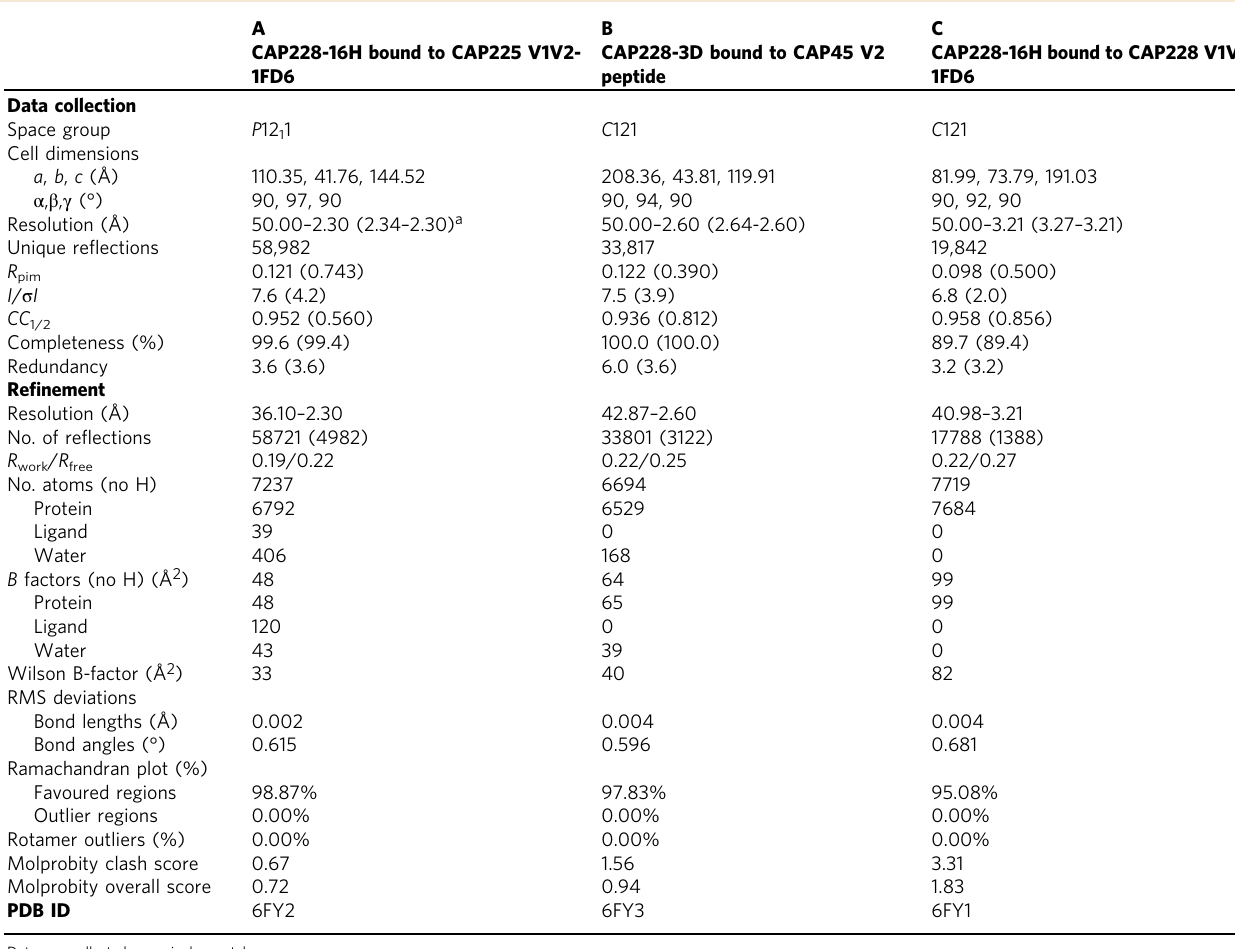
Table 1 X-ray crystallographic data and re fi nement statistics (molecular replacement) for the antigen binding fragments of the CAP228 antibodies in complex with various V2